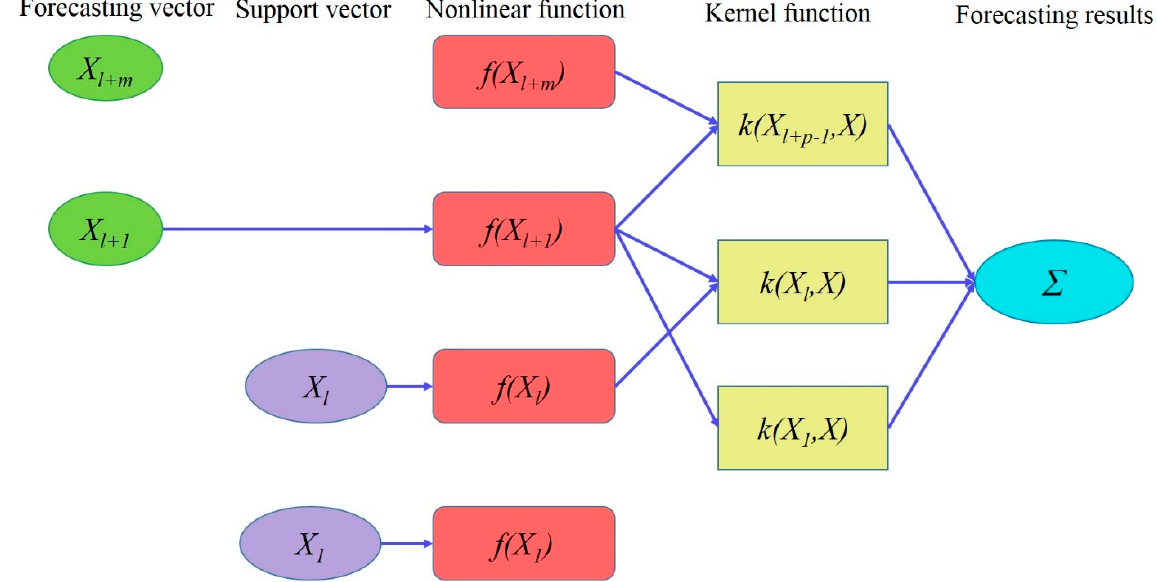
Figure 2. LSSVM structure for modeling the C d of triangular side ori fi ce.